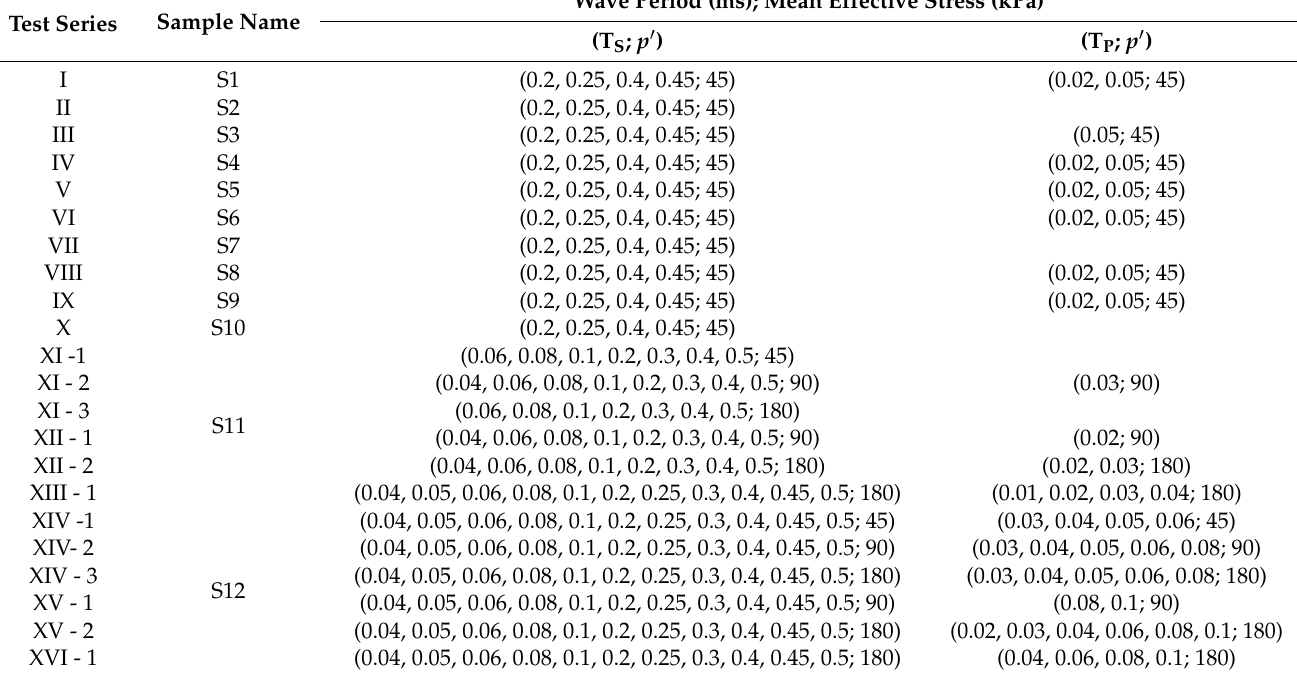
Table 2. Summary of test